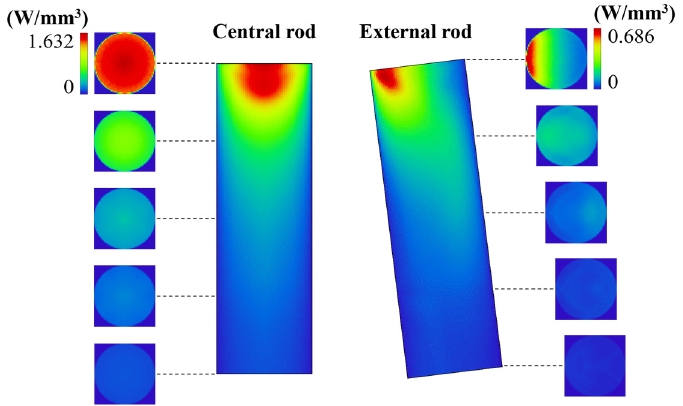
Figure 4. Absorbed pump flux distribution in the longitudinal and five transversal cross-sections of the central and one external Nd:YAG rods, with 4.00 mm diameter and 13 mm length.